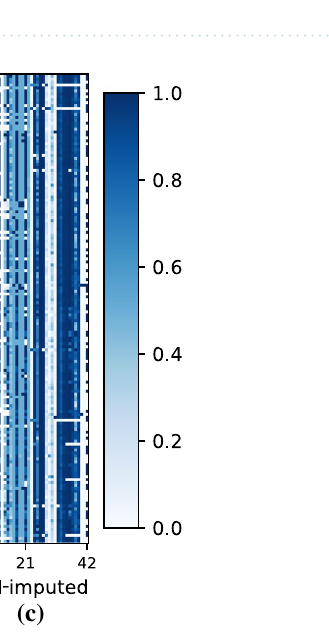
Figure 3. Test accuracy and F1 score for imputation models on the ( a ) Gas, ( b ) SWaT, and ( c ) COVID datasets, for the MPAR corruption strategy.